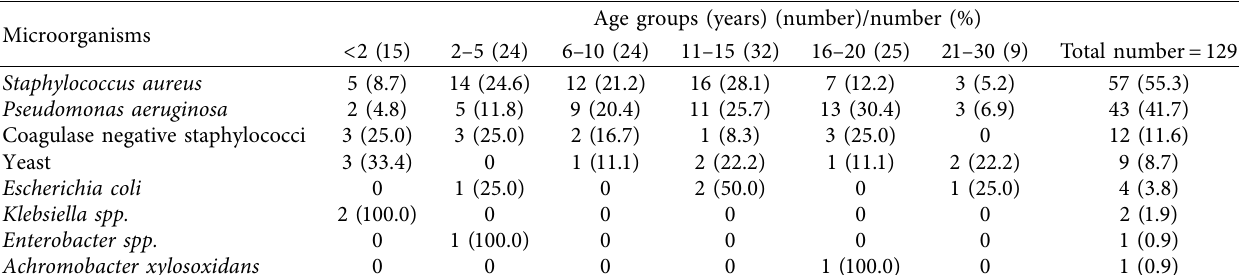
Table 2: Distribution of microorganisms in diferent age groups.